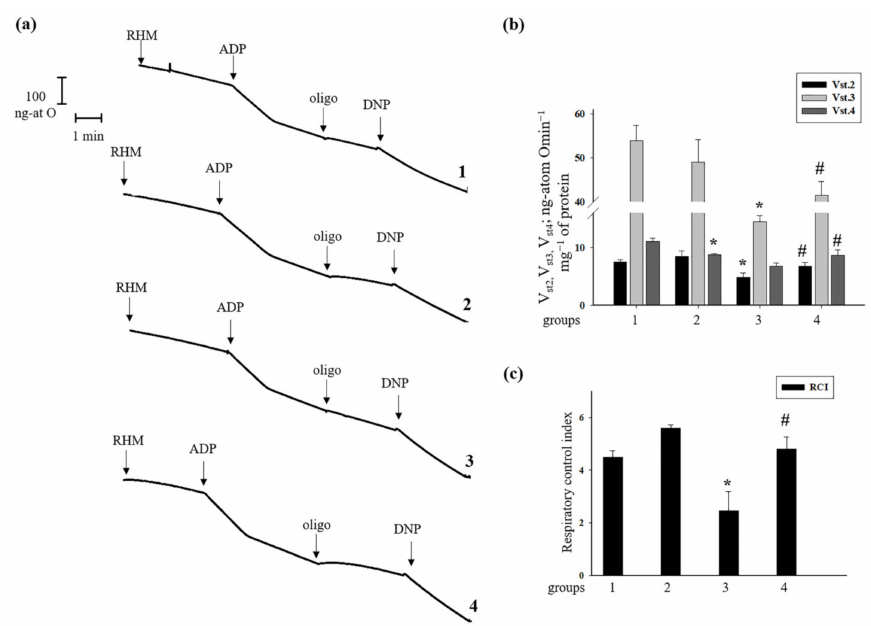
Figure 2. E ff ects of administration of AST and ISO on respiratory activity in rat heart mitochondria. Rat heart mitochondria (RHM) were incubated in standard medium, as described in Materials and Methods. Arrows show the times at which ADP (adenosine 5‘-diphosphate, 150 µ M), oligo (oligomycin, 1.5 µ M), and DNP (2,4-dinitrophenol, 30 µ M) were added. ( a ) Curves of respiratory activity; ( b ) quantitative analysis of RHM respiration rate in states 2, 3, and 4; ( c ) RCI (respiratory control index) values. The data are presented as the means ± SDs of four independent experiments. * p < 0.05 compared with control (group 1). # p < 0.05 compared with RHM isolated from ISO-injected rats (group